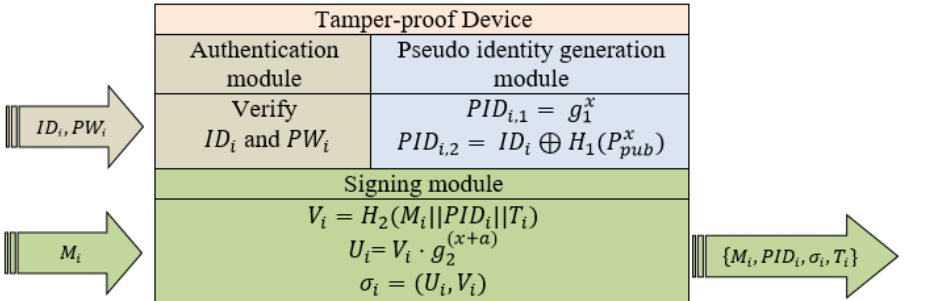
Figure 2. The tamper-proof device for Scheme I